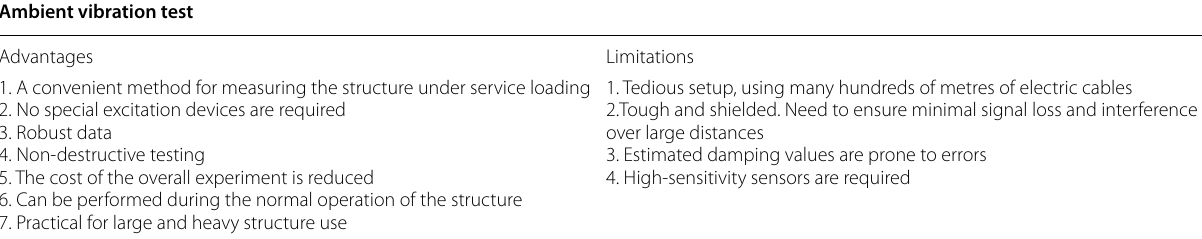
Table 3 Summarisation of the advantages and limitations of the ambient vibration testing Ambient vibration test